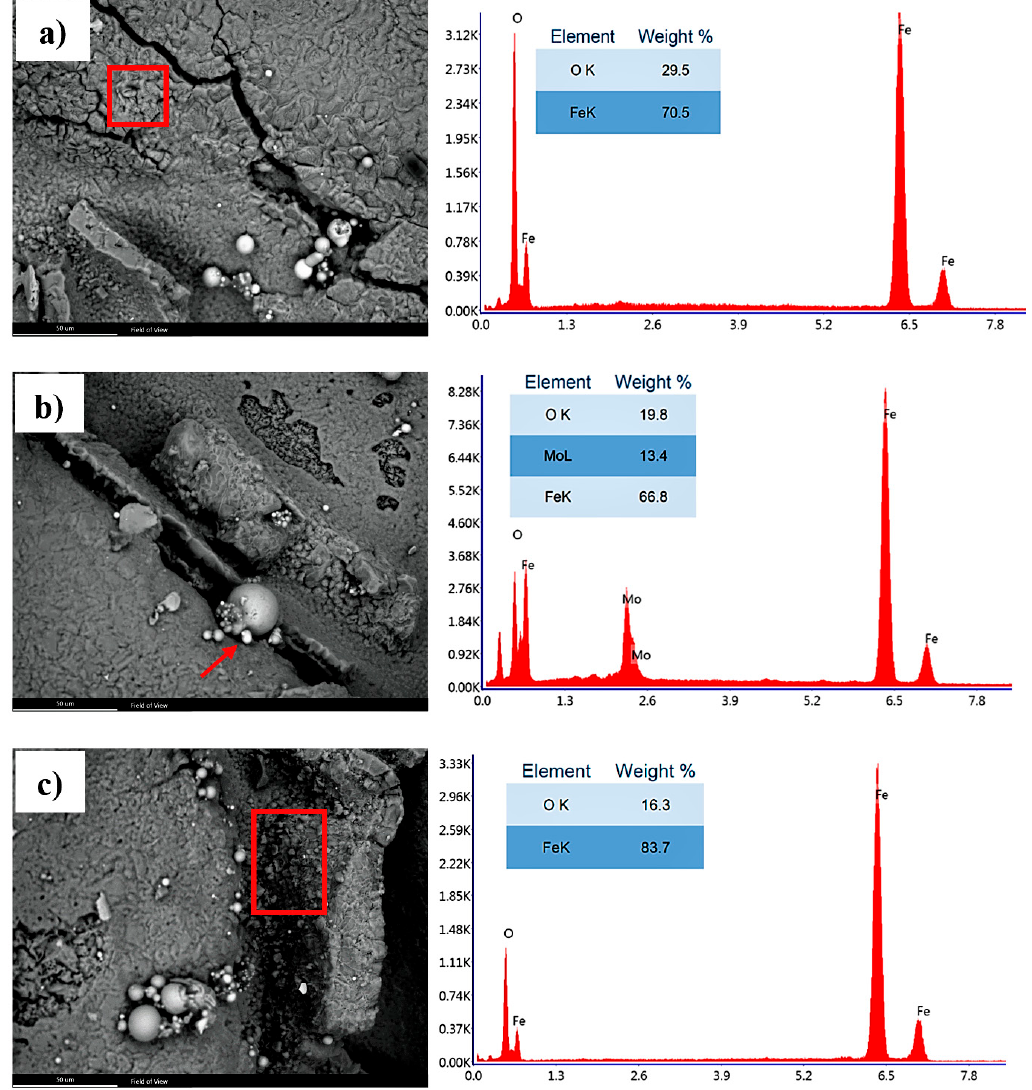
Figure 5. SEM images and energy dispersive X-ray spectroscopy (EDS) analysis of cracks on the surface of a hot-rolled heavy plate. The highlighted spot is analyzed by EDS. ( a ) Surface area surrounding crack, ( b ) rounded white particles, and ( c ) small particles inside cracks.